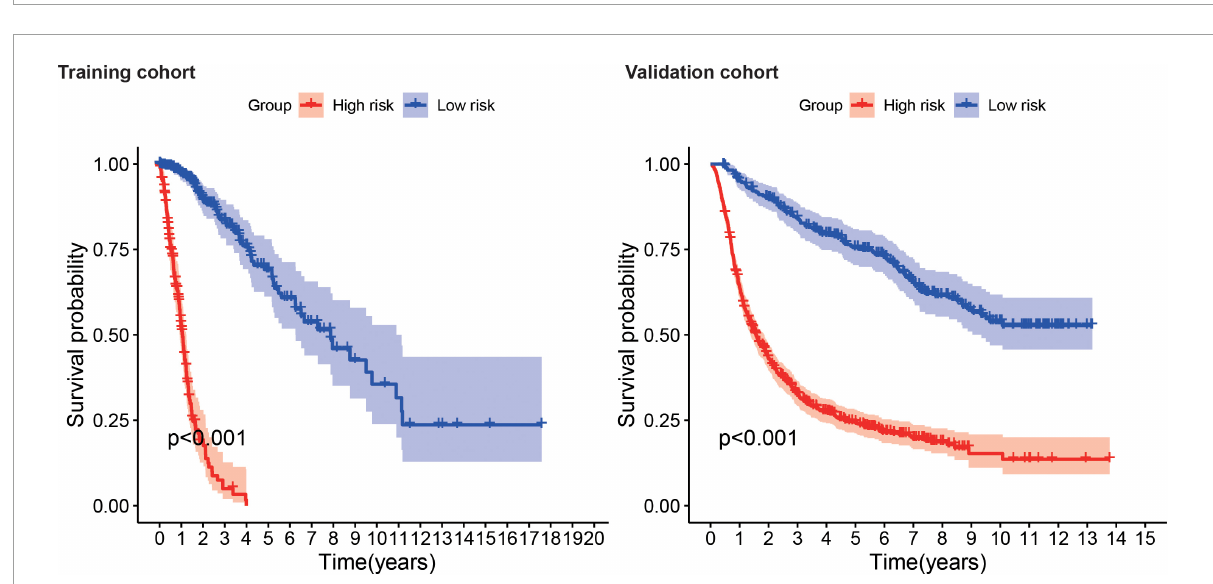
FIGURE6 Survival analysis shows survival probability curves in the training and validation cohort.